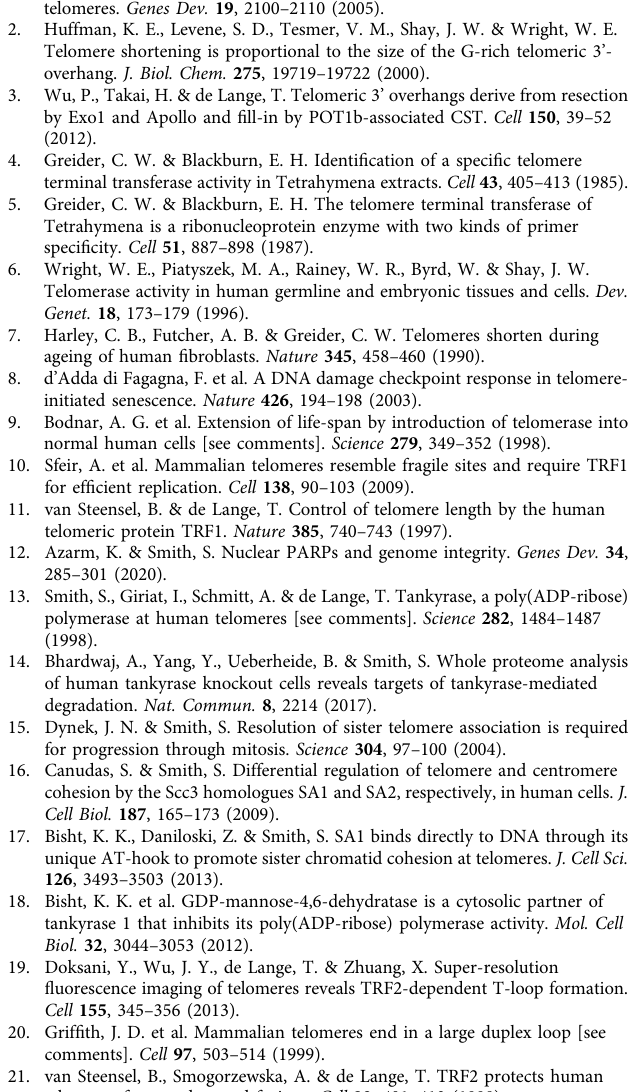
Fig. 7 Subtelomere recombination accompanies senescence onset. a FISH analysis of late IMR90 mitotic cells at PD48 and the fi nal PD51 with a dual 13q arm (red) and telo (green) probe. b Quanti fi cation of the frequency of mitotic cells with cohered 13q arms (red) or telos (green). Average of two independent experiments ( n ≥ 25 cells each). c Table of 13q FISH categories scored in IMR90 cells at PD48, 50 and 51. Average of two independent experiments ( n ≥ 25 cells each) ± SEM. d FISH analysis of a fi nal PD51 IMR90 mitotic cell exhibiting subtelomere, but not arm, copying using a dual 13q arm (red) and telo (green) probe. e Quanti fi cation of the frequency of mitotic cells exhibiting subtelomere or arm copying. Average of two independent experiments ( n ≥ 25 cells each). f FISH analysis of late WI38 mitotic cells at PD52 and the fi nal PD54 with a dual 13q arm (red) and telo (green) probe. g Quanti fi cation of the frequency of mitotic cells with cohered 13q arms (red) or telos (green). Average of two independent experiments ( n ≥ 32 cells each). h Table of 13q FISH categories scored in late WI38 mitotic cells at PD 52, 53, and the fi nal PD54. Average of two independent experiments ( n ≥ 32 cells each) ± SEM. i FISH analysis of a fi nal PD54 WI38 mitotic cell exhibiting subtelomere, but not arm, copying using a dual 13q arm (red) and telo (green) probe. j Quanti fi cation of the frequency of mitotic cells exhibiting subtelomere copying. Average of two independent experiments ( n ≥ 32 cells each). a , d , f , i DNA was stained with DAPI (blue). Scale bars represent 2 μ m. Experiments were repeated independently twice (for a , d , f , i ) with similar results. Source data are provided as a Source Data fi